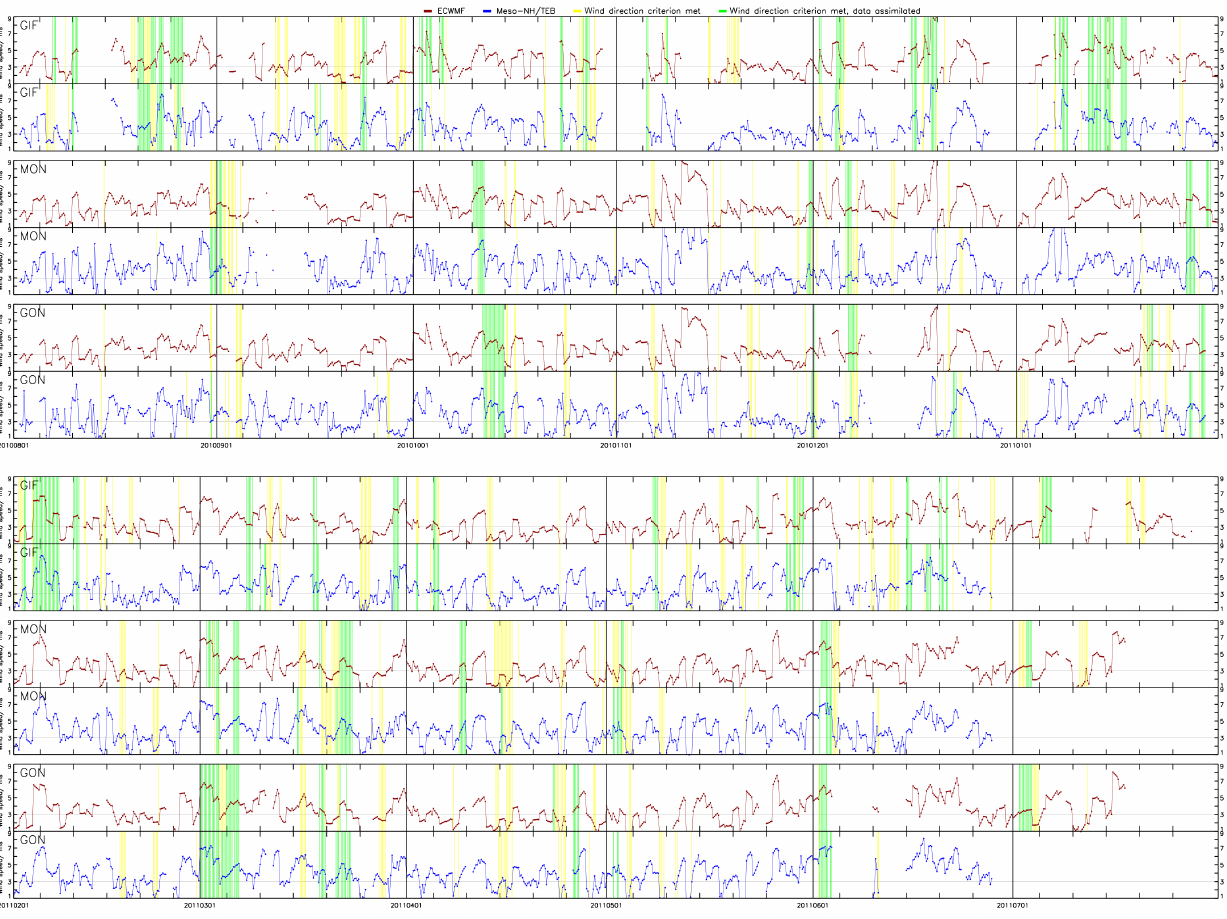
Figure A2. Time series of mean wind speed during the afternoon (12:00–16:00) at the different monitoring sites used in this study. Solid horizontal lines: 3ms − 1 wind speed threshold. Red: wind speed as simulated by ECMWF. Blue: wind speed as simulated by Meso-NH/TEB. Yellow vertical lines: wind directions are within the range of wind directions used by the reference (stringent) gradient selection. Green vertical lines: data are actually assimilated when using the reference (stringent) gradient selection